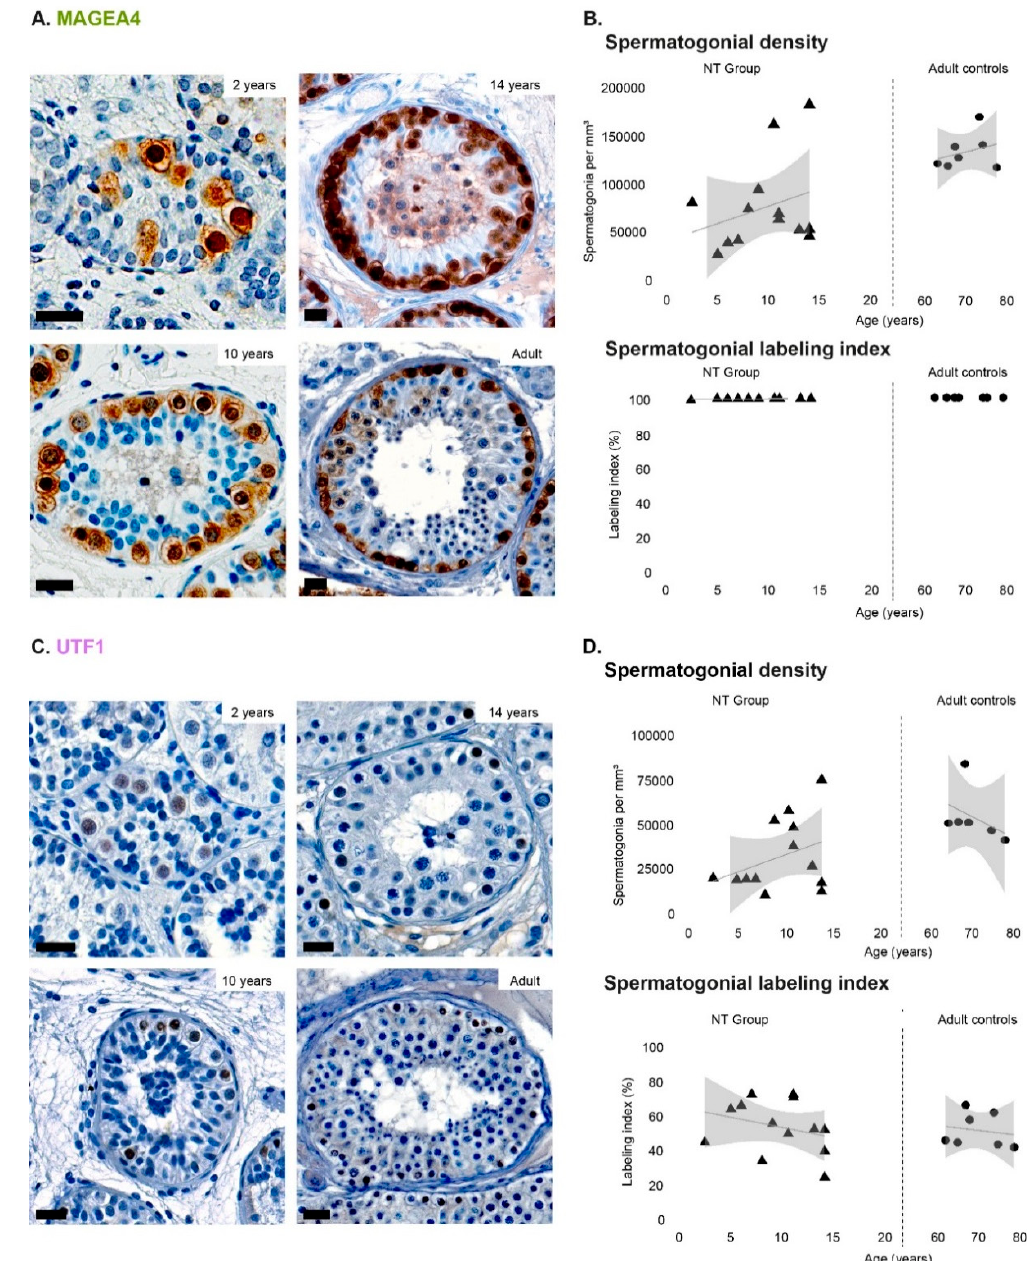
Figure 1. Spermatogonial expression of MAGEA4 and UTF1 throughout age. ( A ) Immunohistochemical identification of MAGEA4-positive (brown) spermatogonia at several testicular developmental stages. Scale bar: 20 µ m. ( B ) Density and labeling index (%) of MAGEA4-positive spermatogonia during normal development (NT group) and adulthood. ( C ) Immunohistochemical identification of UTF1-positive (brown) spermatogonia at several testicular developmental stages. Scale bar: 20 µ m. ( D ) Density and labeling index (%) of UTF1-positive spermatogonia during normal development (NT group) and adulthood. Individual values, trend line, and 95% confidence interval are represented. Generalized linear models were used to predict the response of labeling index based on the patients’ age.